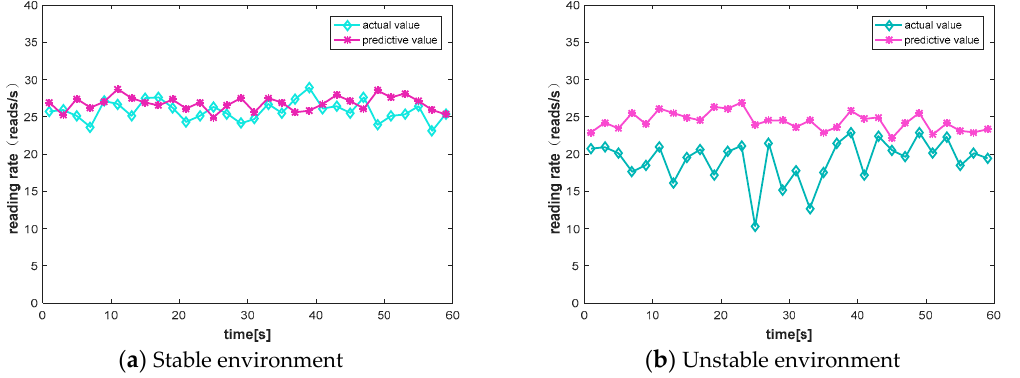
Figure 9. Predictive effect of reading rate.